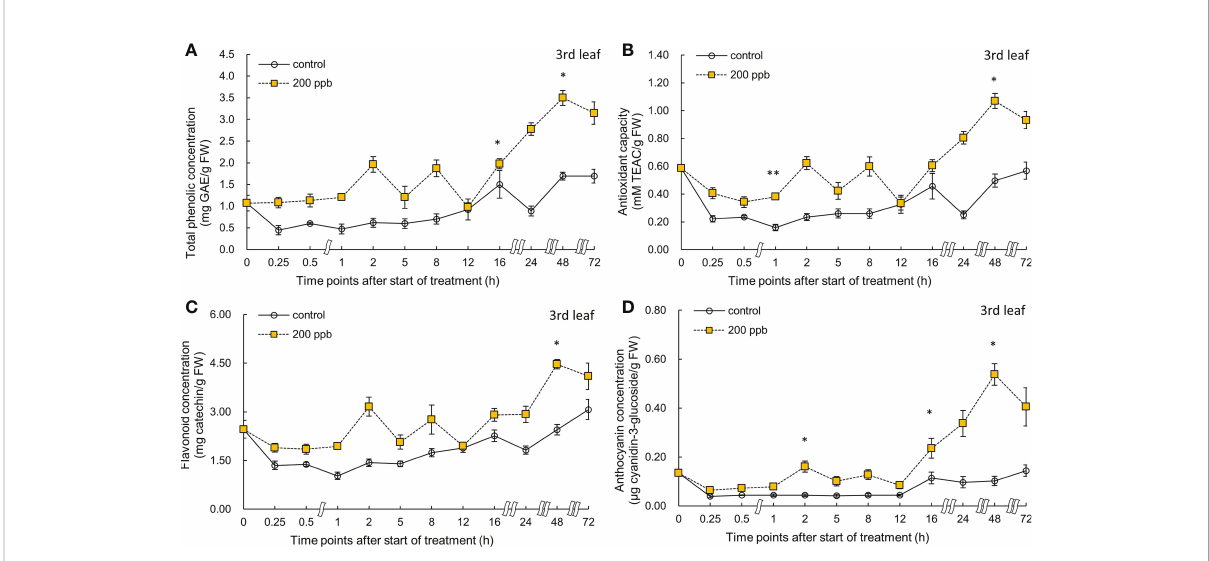
FIGURE 8 Total phenolic concentration (A) , antioxidant capacity (B) , total fl avonoid concentration (C) , and anthocyanin concentration (D) of third red leaf lettuce subjected to 200-ppb ozone treatment for 72 h. The vertical vars indicate SE (n=4). Statistically signi fi cant differences are indicated at * p < 0.05 and ** p < 0.01 by